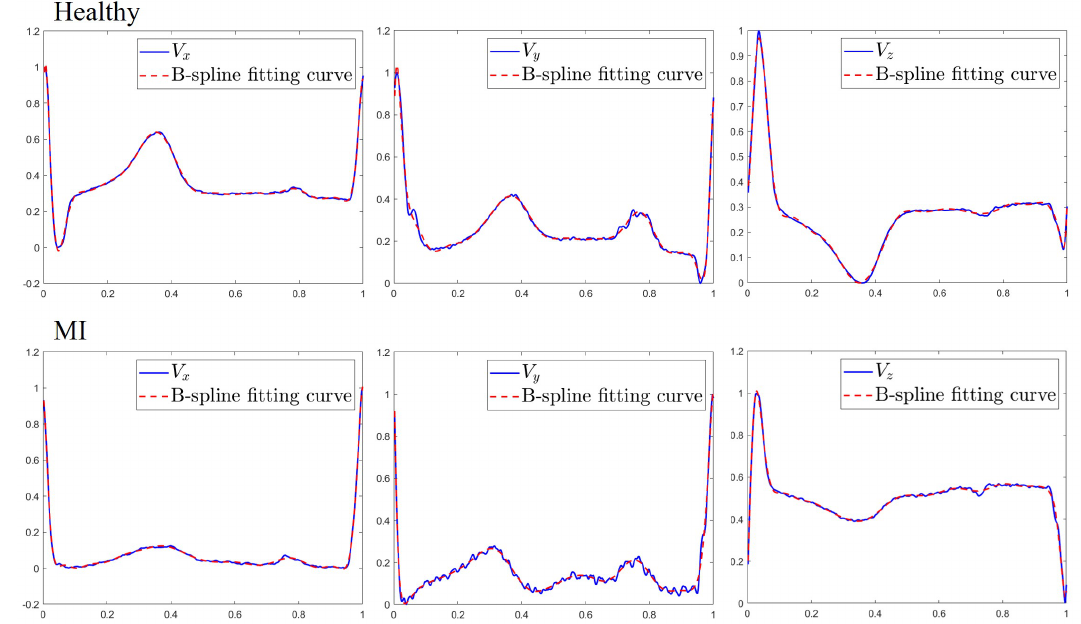
Figure 6. Comparison between original heartbeats ( blue ) and fitting curves ( red ) for healthy and MI